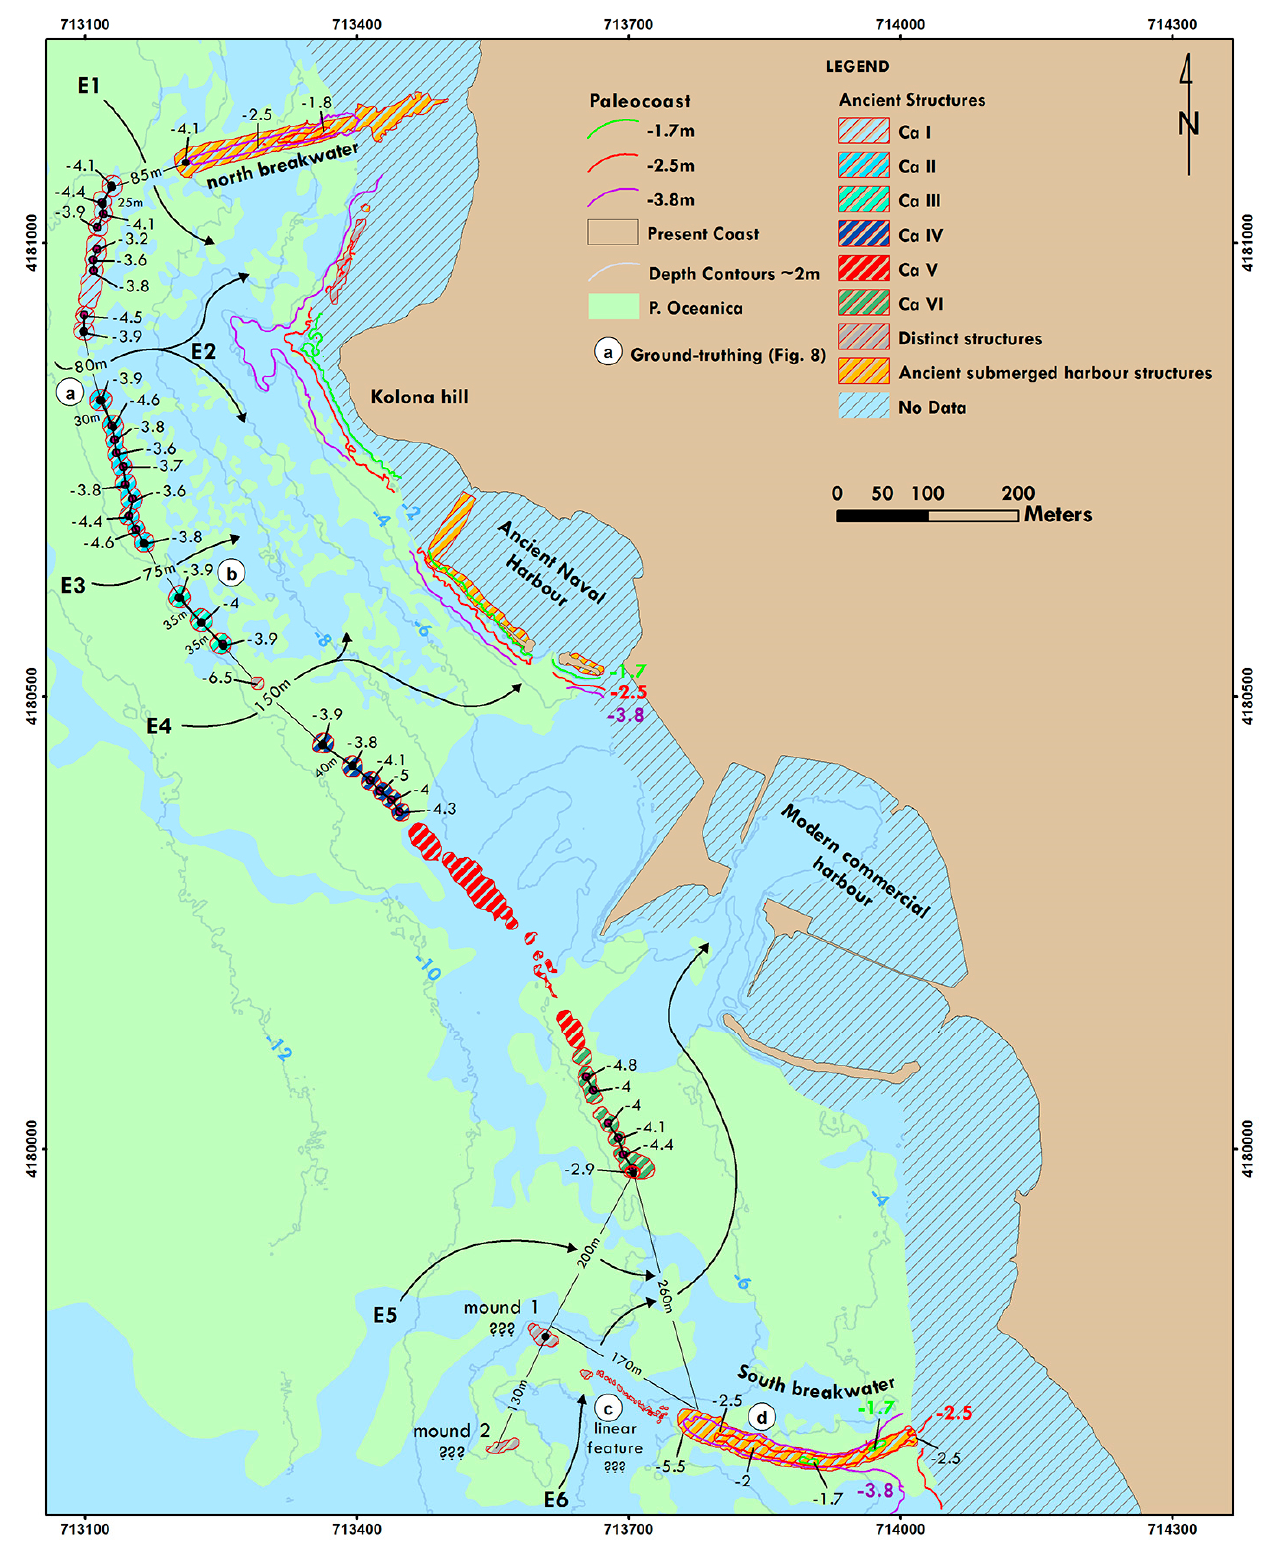
Figure 7. Map showing the extent of the submerged structures (system of conical rubble structures) detected by the geophysical survey and classification, the possible passages to the protected maritime area and their width, the paleocoasts for depths of − 3.8, − 2.5, − 1.7 m (purple, red, green). Letters a – d represent the location of the ground-truthing survey shown in Figure 8.